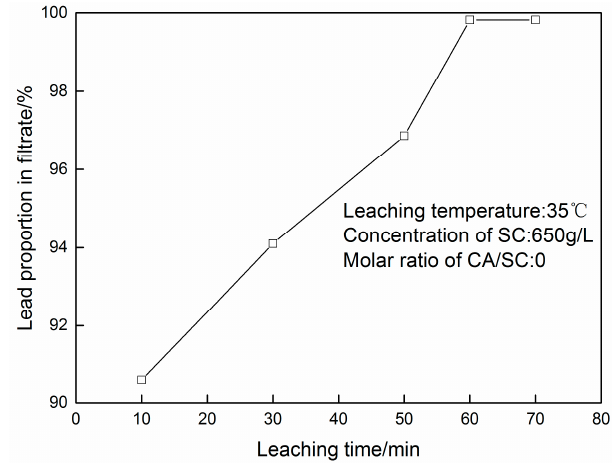
Figure 1. Lead proportion in filtrate with different leaching time (leaching temperature is 35 °C, concentration of SC is 650 g/L, molar ratio of CA/SC is 0).